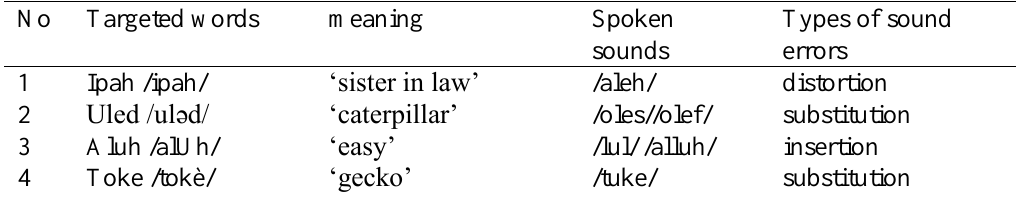
Table 1 Form and Types of Phonological Errors in Words